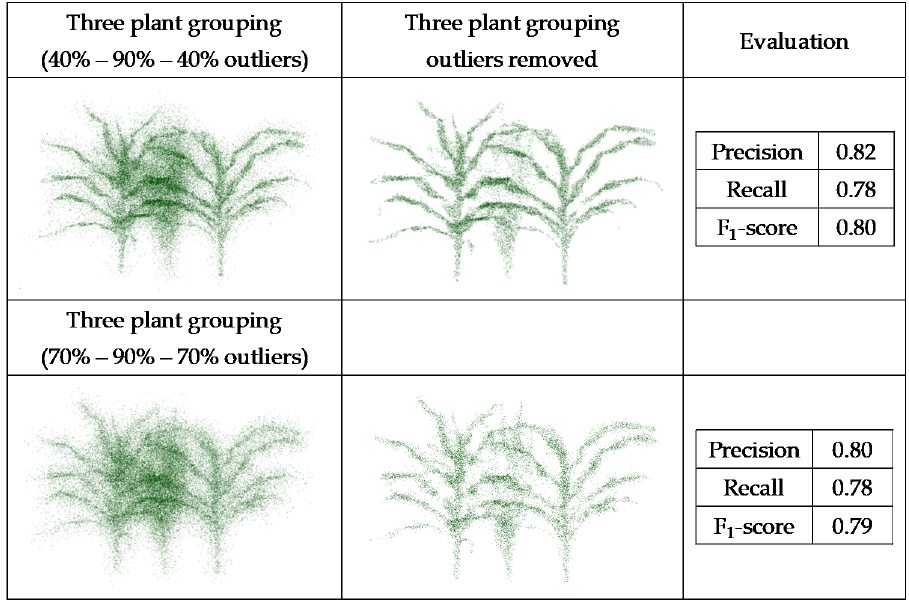
Figure 17. PointCleanNet outlier removal on joint point cloud generated from three sorghum plants grouping.